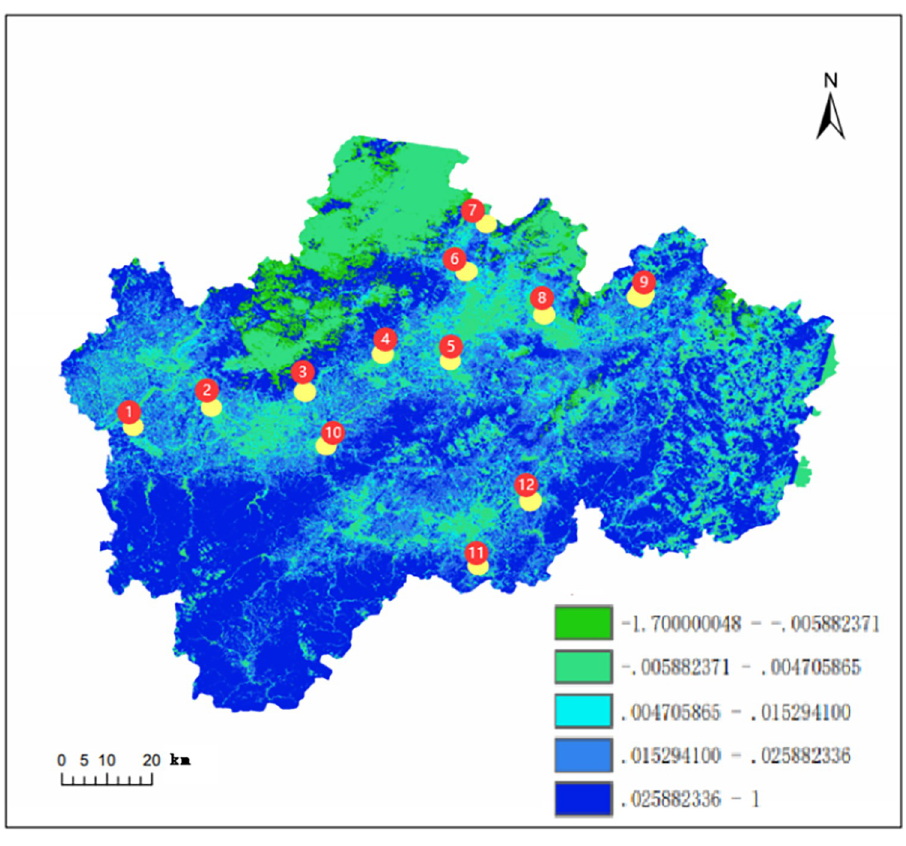
Fig 4. Schematic diagram of the interchange